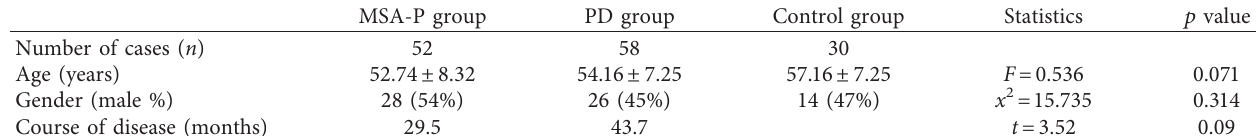
Table 1: Comparison of general data among the MSA-P group, PD group, and control group.